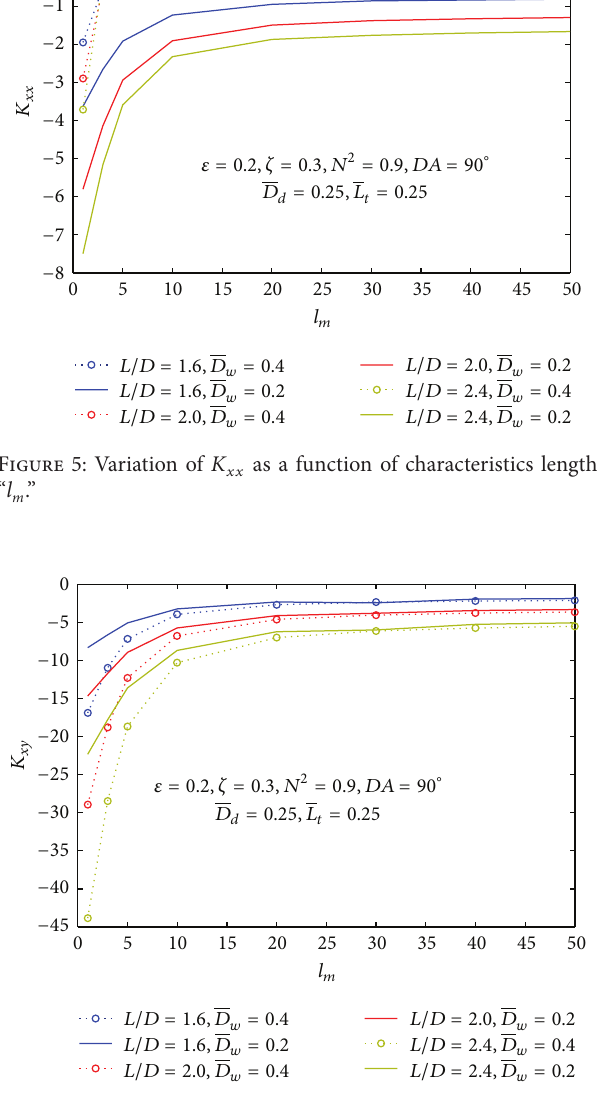
Figure 6: Variation of K 𝑥𝑦 as a function of characteristics length .” “ l m